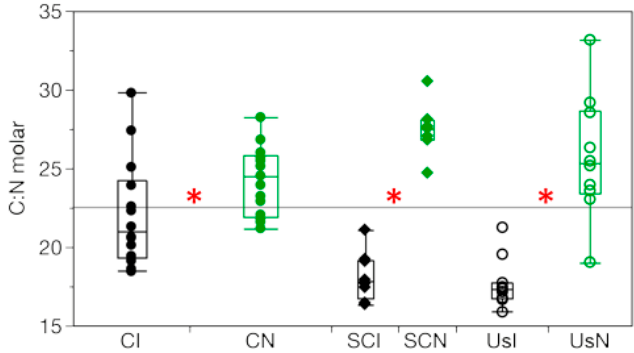
Figure 4. Vertical variation in leaf C:N ratios for C. elastica (I) (black symbols) and grouped native species (N) (green symbols) measured in the canopy (C), sub-canopy (SC), and understory (Us) of a Castilla novel forest. The stars indicate significant differences between groups within each stratum (Wilcoxon test, p < 0.05). Overall comparison between C. elastica and the group of native species: Wilcoxon/Kruskal-Wallis test χ 2 = 44, 0.001 < χ 2 < p .